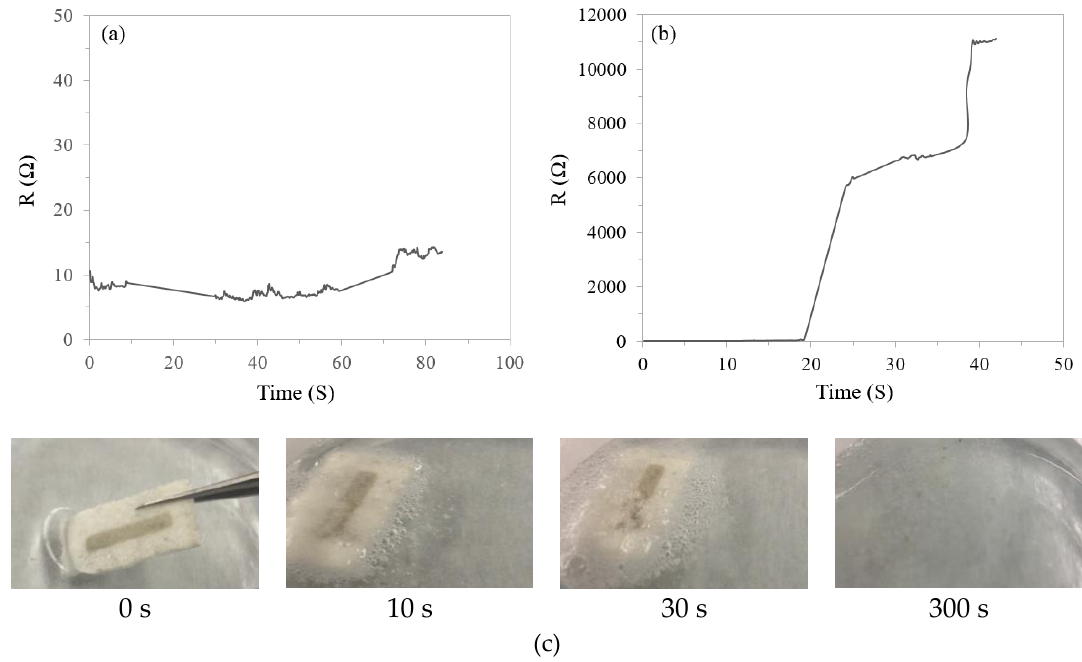
Figure 4. Transiency of a straight conductive path fabricated on ( a ) GPVA-PEO substrate and ( b ) 0.5 A substrate quantified from loss of electrical conductivity when exposed to DI water (1.5 % reading accuracy for resistance); ( c ) sequential images of gas formation and transiency of 0.5 A substrate with a straight conductive path.